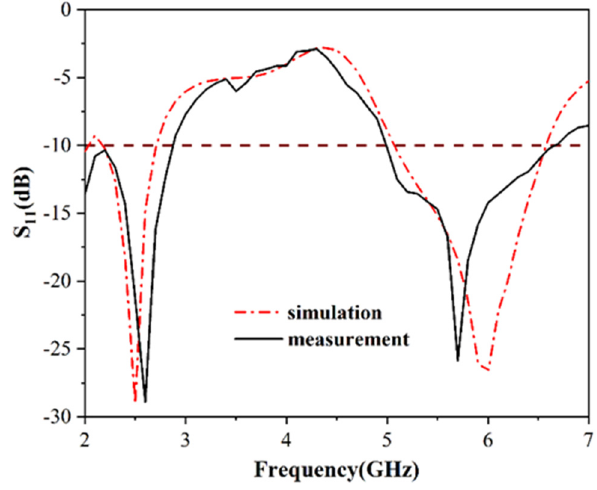
Figure 7. Simulated and measured reflection coefficients of the proposed antenna.